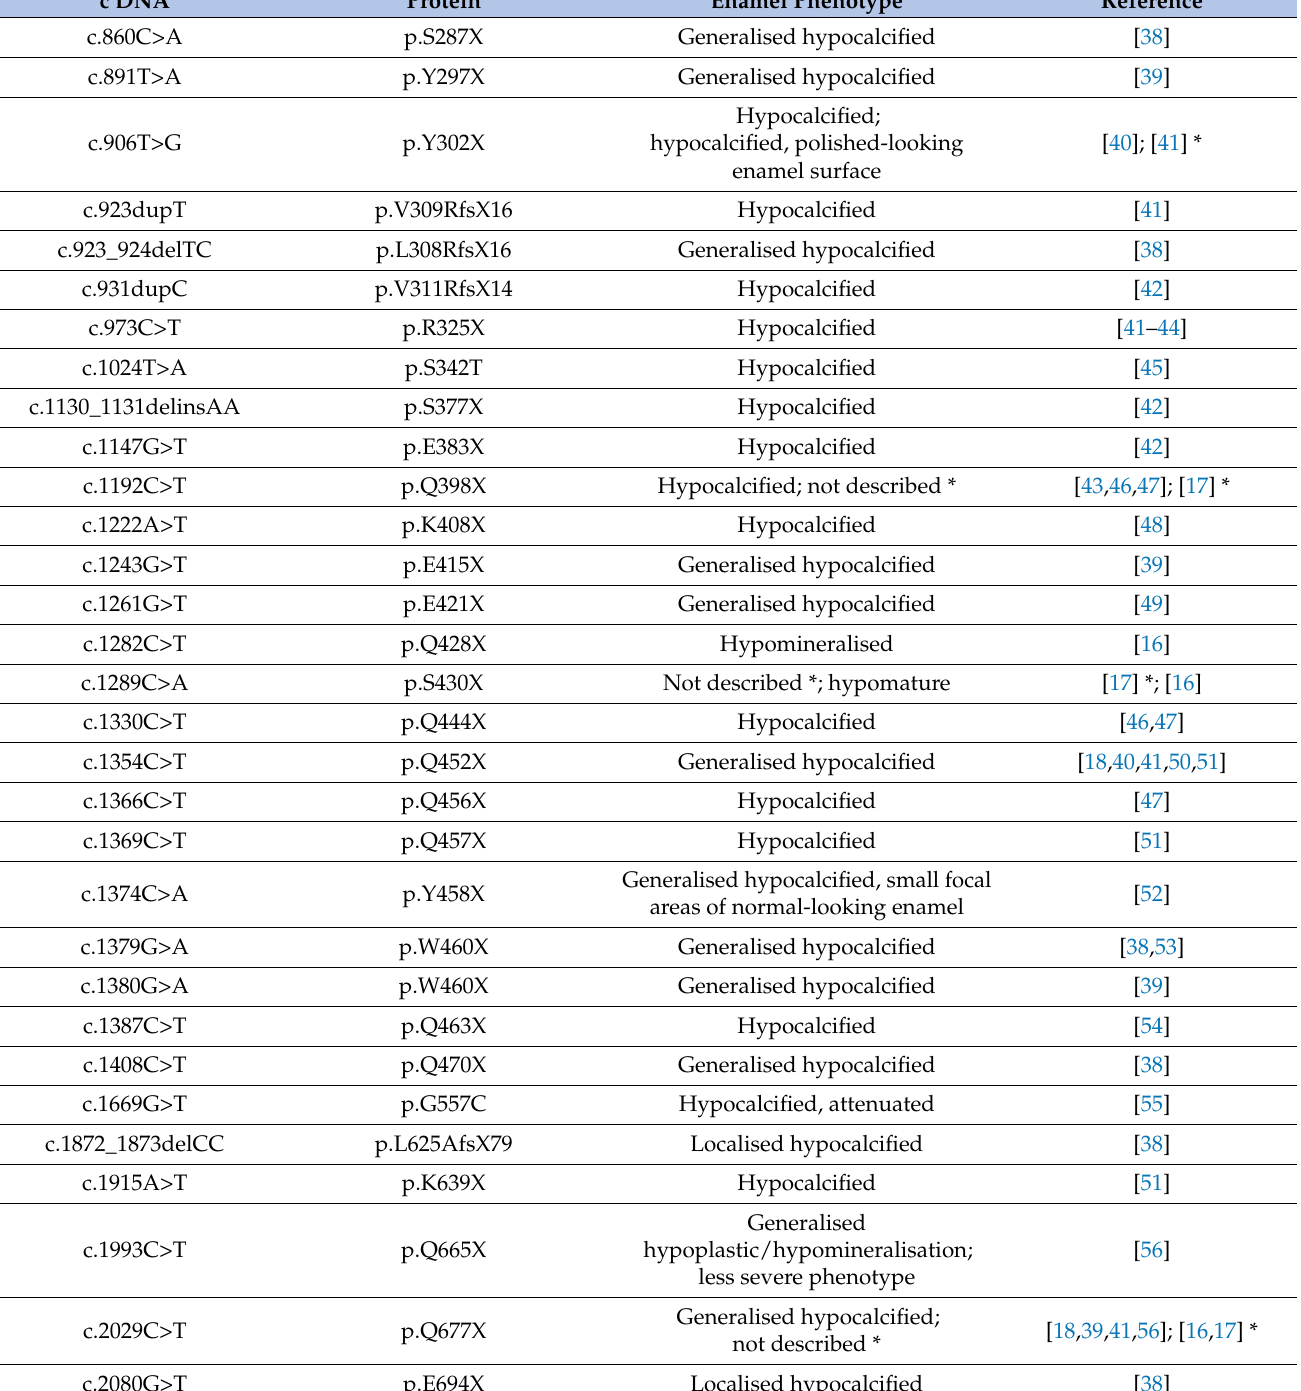
Table 2. Review of the disease-causing FAM83H gene (NM_198488.5) variants and related clinical